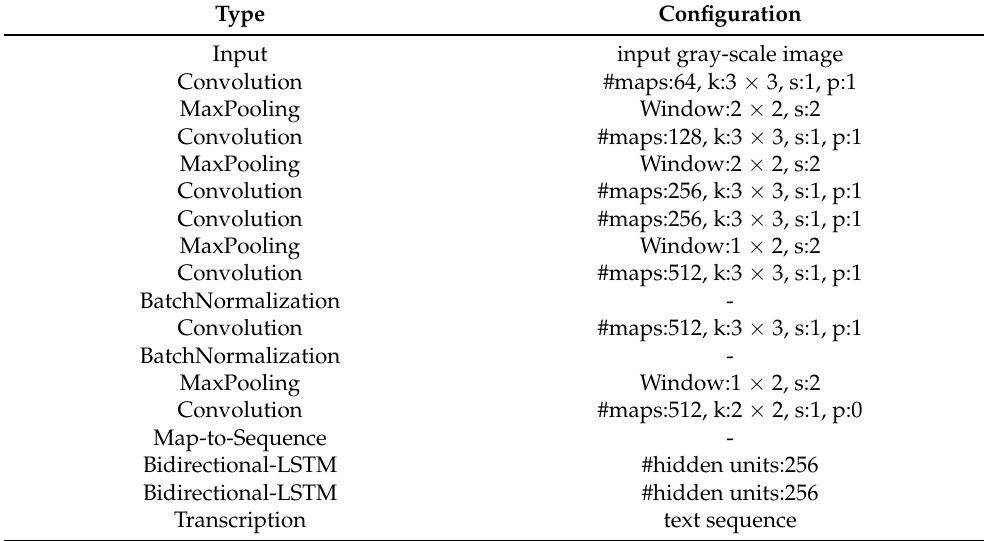
Table A2. Network configuration summary of CRNN. ‘k’, ‘s’, and ‘p’ stand for the kernel size, stride size, and padding size,